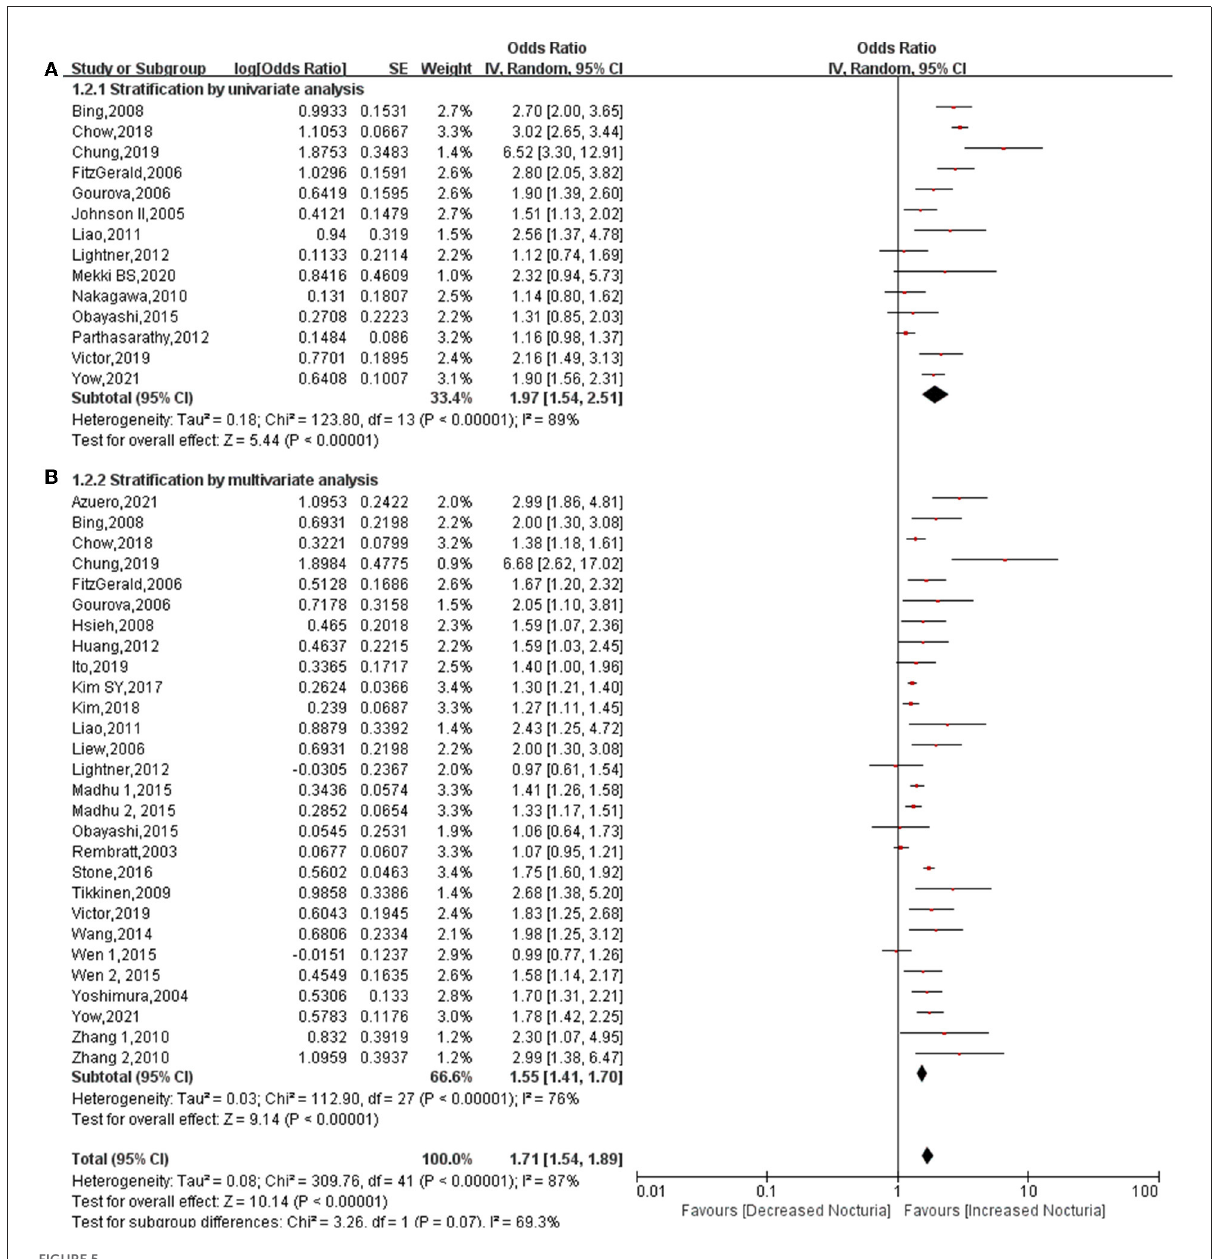
FIGURE5 Forest plot for the association between diabetes and nocturia stratified by univariate analysis (A) and multivariate analysis (B)